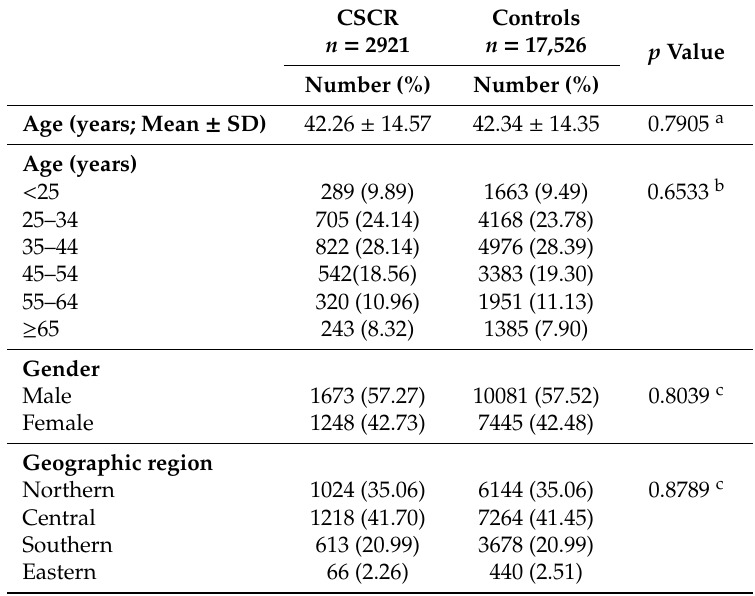
Table 1. Baseline characteristics of central serous chorioretinopathy (CSCR) patients and control group patients after propensity score matching.